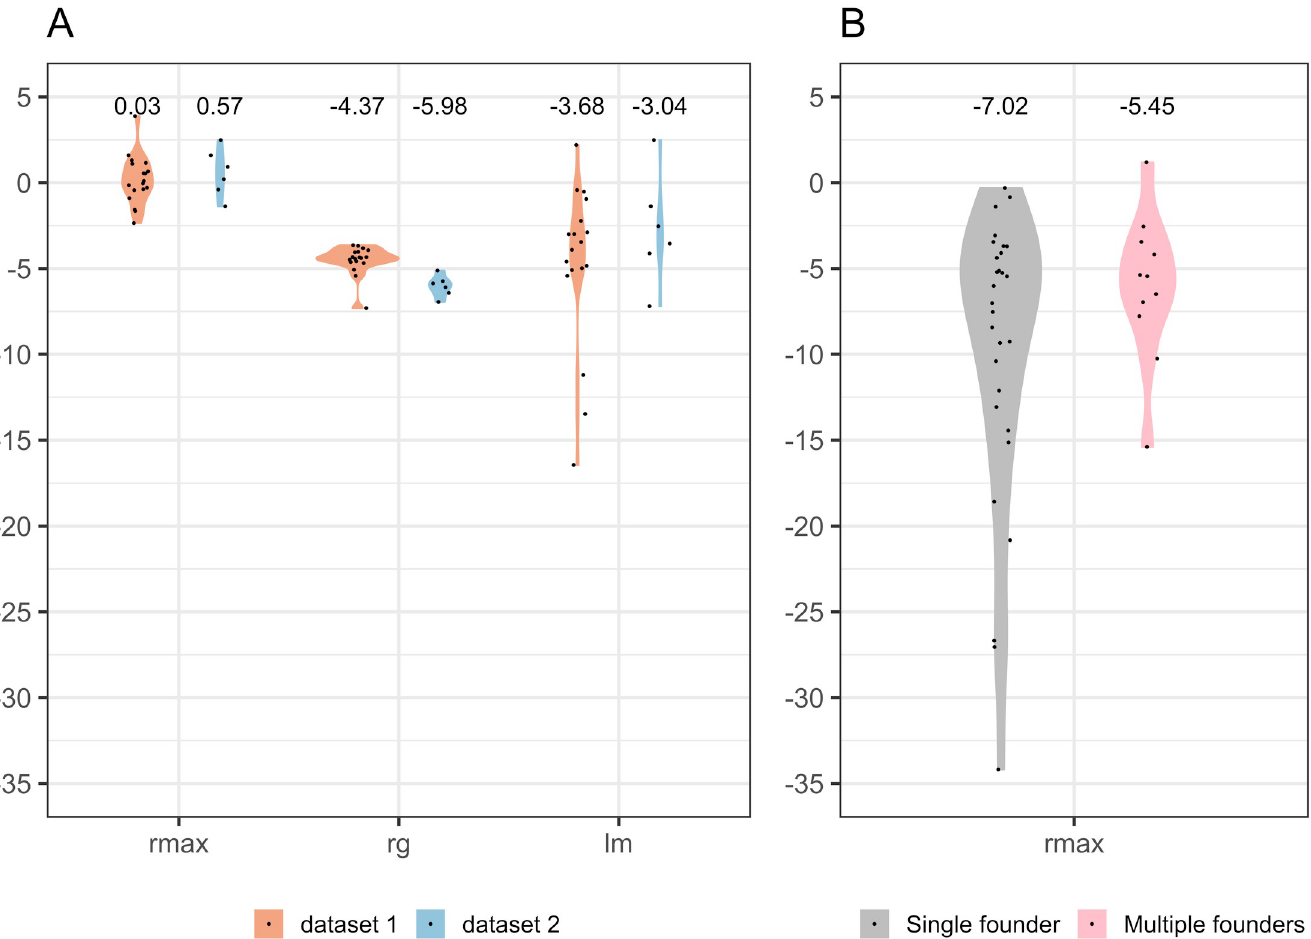
Fig 4. Estimated infection dates based on viral growth rates. The date when viral loads corresponded to 1 copy per mL of blood was calculated using three methods: highest expansion (r max ), individual linear models (lm) and linear mixed-effects model based on data from all subjects (r g ). Panel A compares the estimates in two non-human primate (NHP) cohorts with viral load data provided by Drs. Barouch (dataset 1) and Roederer (dataset 2). Panel B shows the estimates calculated with r max for RV217 participants infected with single or multiple HIV-1 founder viruses. Day 0 corresponds to the day of challenge for the NHP in Panel A and to the day of the first positive HIV-1 RNA test for RV217 participants (Panel B).